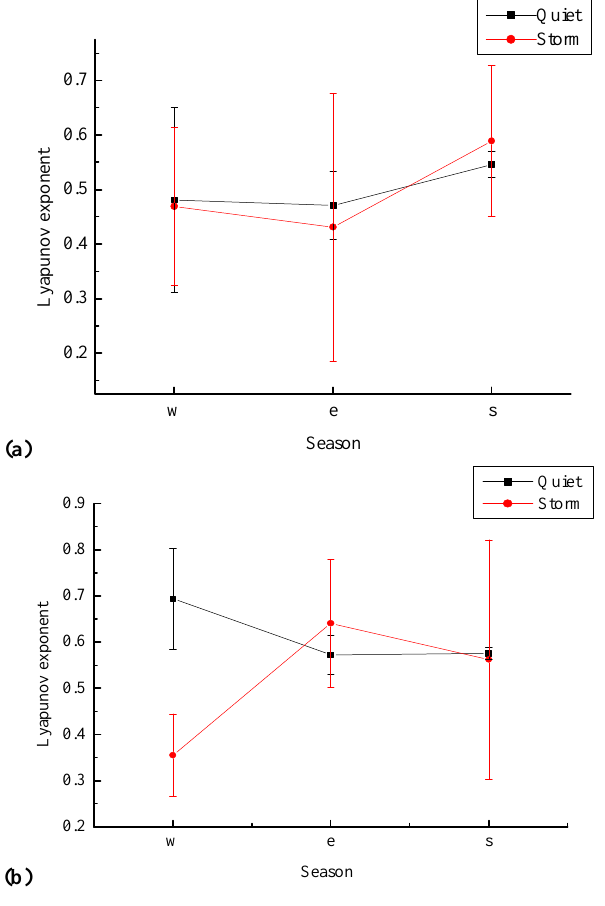
Figure 4b Fig. 4. Comparison of seasonal mean values of Lyapunov exponent of AE index time series for summer, equinox and winter (denoted by letters, “s”, “e”, and “w”, respectively on X axis), during storm and quiet periods (red and black lines respectively) of (a) high (1991) and (b) low (1994) solar activity years. The vertical bars represent the standard deviation (red for storm and black for quiet